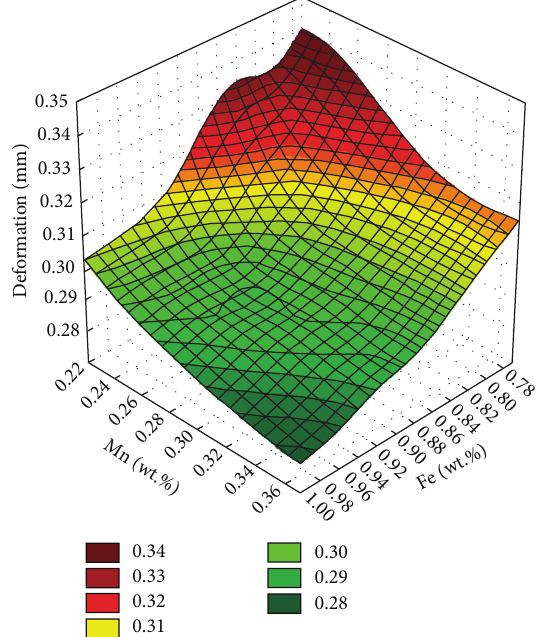
Figure 3: Dependence of permanent deformation on iron and